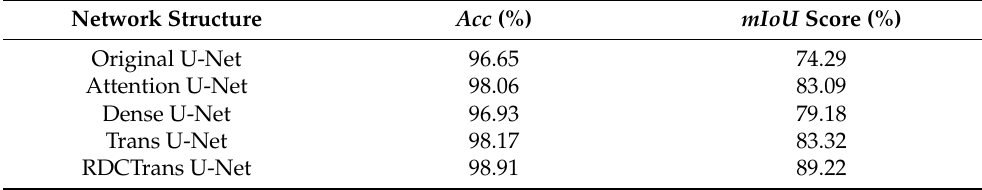
Table 1. Comparison of overall segmentation performance of each model on LiTS dataset.